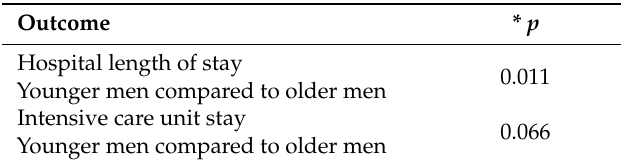
Table 4. Multivariable regression analysis for the association between younger men and outcomes compared to older